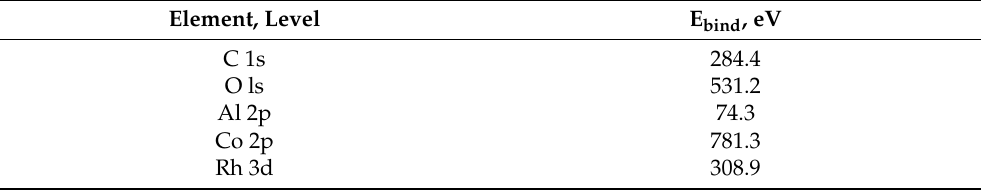
Table 2. XPS data on binding energy for the components of 5%Co-Rh(l:l)/Al 2 O 3 catalyst. Element,